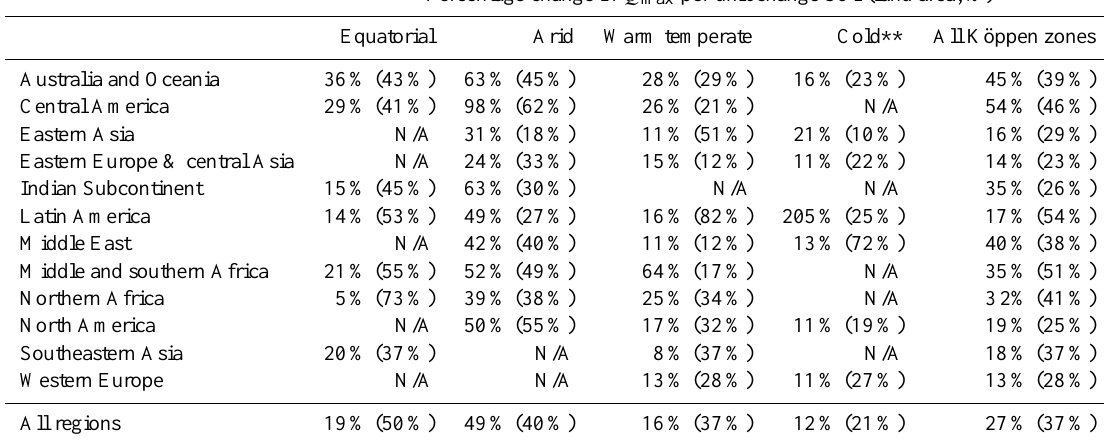
All regions * Area-weighted percentage change in Q max per unit change SOI for basins with significant correlations between ln Q max and SOI, and percentage of land area (shown in brackets) with significant correlations. Results shown per geographical region and Köppen climate region. ** Köppen regions “polar” and “snow” have been combined here into one ‘cold’ region. Greenland and Antarctica are excluded from the